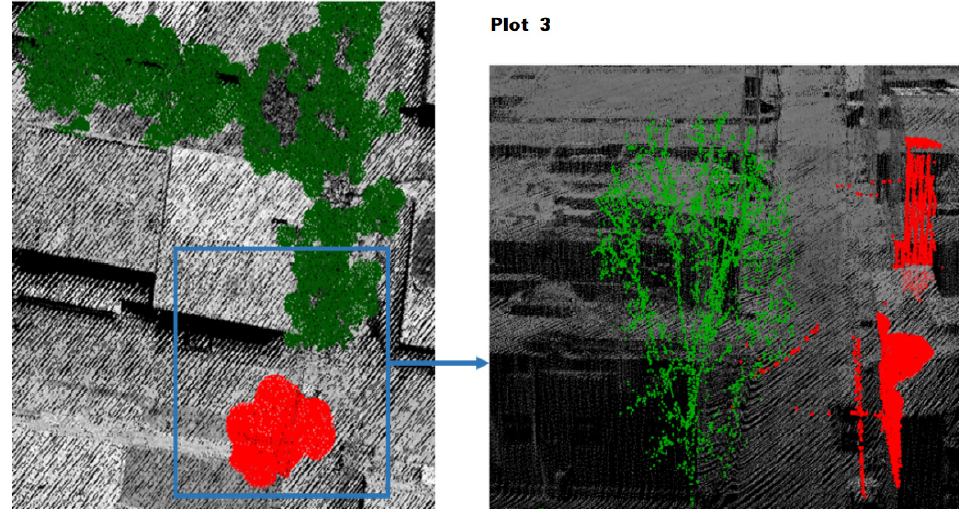
Figure 11. Building edges with overhanging wires that were mistakenly extracted as trees (red points).